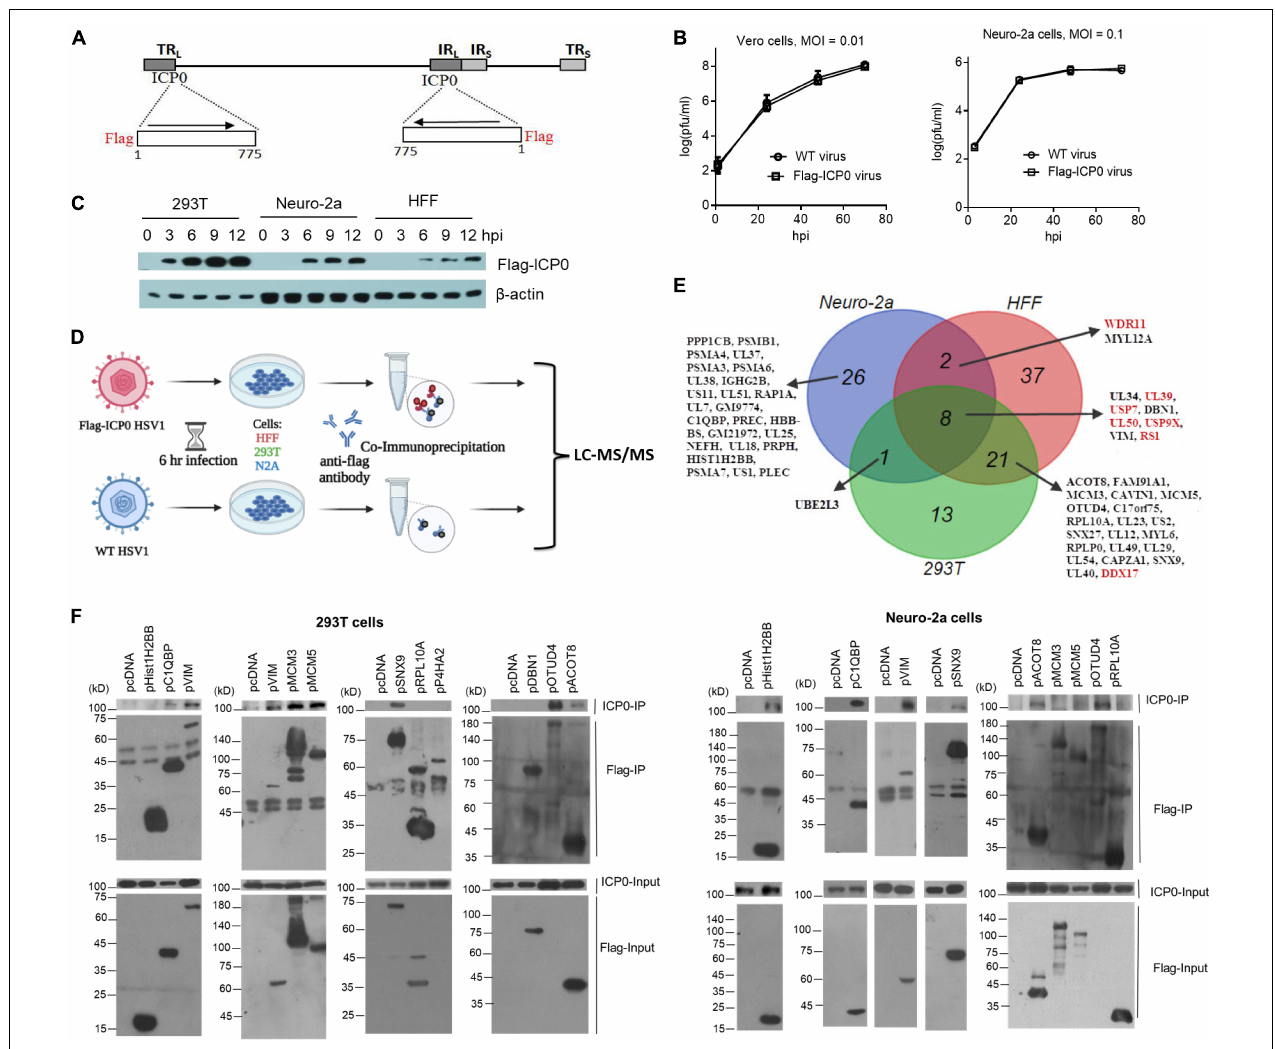
FIGURE 2 | ICP0-interactome analysis. (A) Diagram of recombinant Flag-ICP0 virus. The horizontal line at the top represents HSV-1 genome and the boxes labeled with TR L , IR L , TR S , and IR S represent the repeated sequences. At the bottom are expanded ICP0 gene regions with the inserted N-terminal Flag tags indicated. (B) Virus growth curves of WT and Flag-ICP0 virus in Vero (left) and Neuro-2a (right) cells after infection at an MOI of 0.01 and 0.1, respectively. Data are presented as mean values ± SD. (C) Neuro-2a, HFF, and 293T cells were infected with Flag-ICP0 virus at an MOI of 10 and cells were lysed at the indicated time points for examination of Flag-ICP0 expression by Western blots with anti-Flag and anti- β -actin antibodies. (D) Schematic diagram of the procedures for ICP0 interactome analysis. Neuro-2a, 293T, and HFF cells were infected with WT (control) or Flag-ICP0 virus for 6 h at an MOI of 20 with three biological replicates. Proteins were immunoprecipitated by the anti-Flag antibody and examined by liquid chromatography with tandem mass spectrometry (LC-MS/MS). (E) Venn diagram showing candidate ICP0-interacting proteins identified by the interactome analysis in the three cell types. Previously reported ICP0-interacting proteins are marked in red. (F) 293T (left) or Neuro-2a (right) cells in each 100-mm plate were co-transfected with 7.5 µ g of an empty vector (pcDNA) or a plasmid expressing the indicated protein linked to a Flag-tag and 7.5 µ g of a plasmid expressing untagged ICP0 for 48 h. After the cells were lysed, the indicated proteins were immunoprecipitated by an anti-Flag antibody and analyzed by Western blots for ICP0 and the corresponding proteins using an ICP0 and Flag antibody, respectively. Results from immunoprecipitated samples (IP) were shown in the upper panels and those from the lysates (Input) were shown in the lower panels. Note that prolyl 4-hydroxylase subunit alpha 2 (P4HA2) and OTUD4 expression from the plasmids were not detected in the input samples due to low expression but were clearly detected in the IP